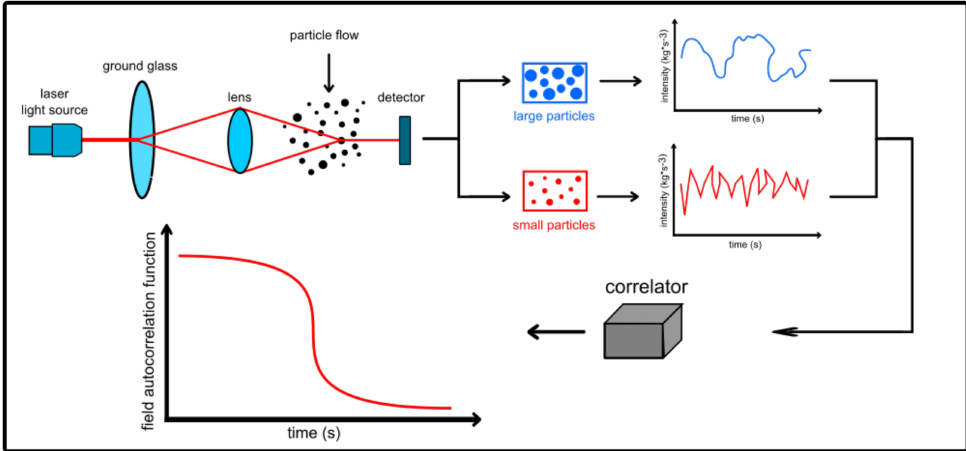
Figure 7. Schematic diagram of a diffusing wave spectroscopy setup with subsequent data analysis.